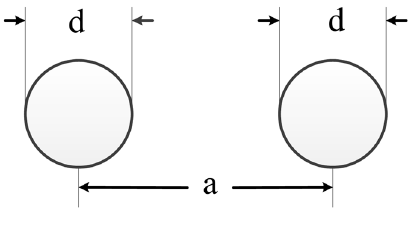
Figure 5. Parallel wires. Figure 5. Parallel